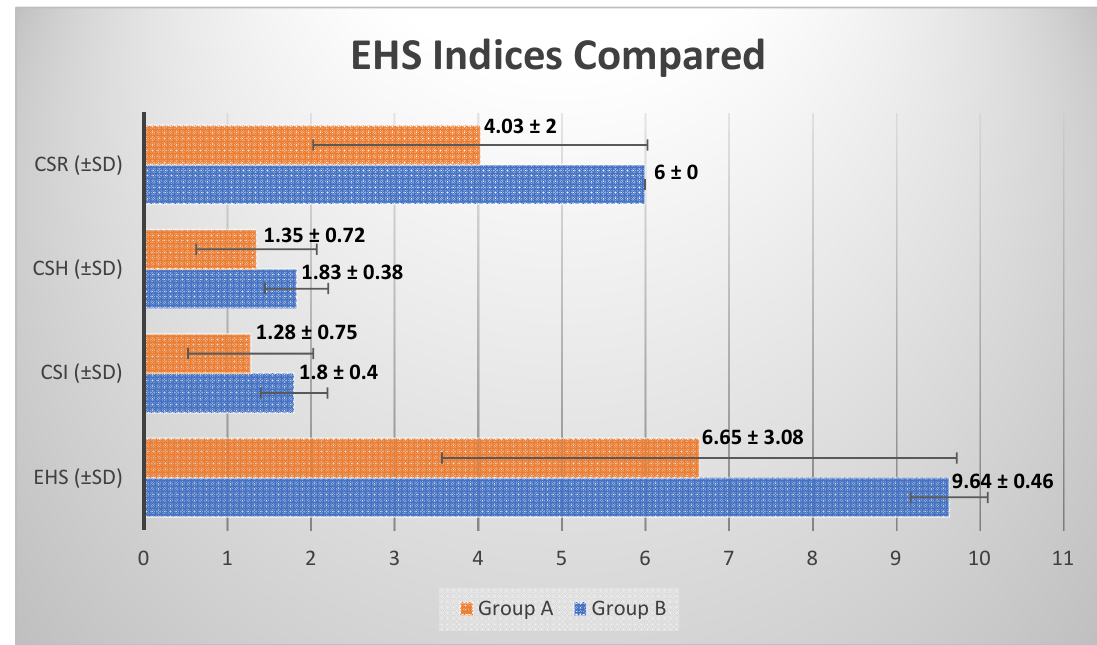
Figure 16. Comparison between the average EHS indices ± SD in Groups A and B. Table 4. Comparison of all the variables considered between Group A and B, with SD and p -Value. Variable Group